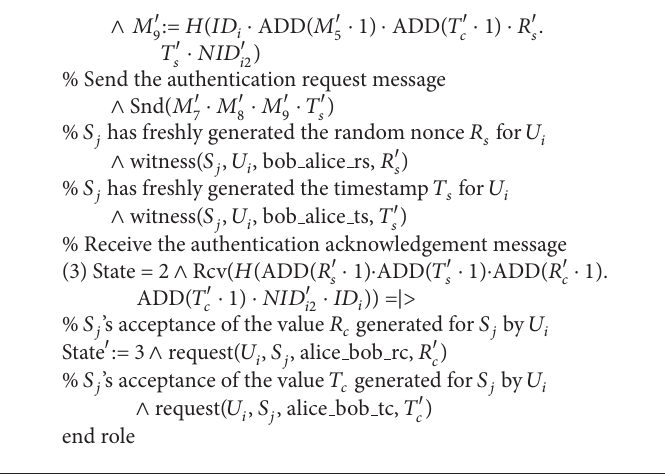
Algorithm 4: Role specification in HLPSL for the server 𝑆 𝑗 of our scheme. Table 5: Comparison of computational overhead between our scheme and other schemes during all phases.